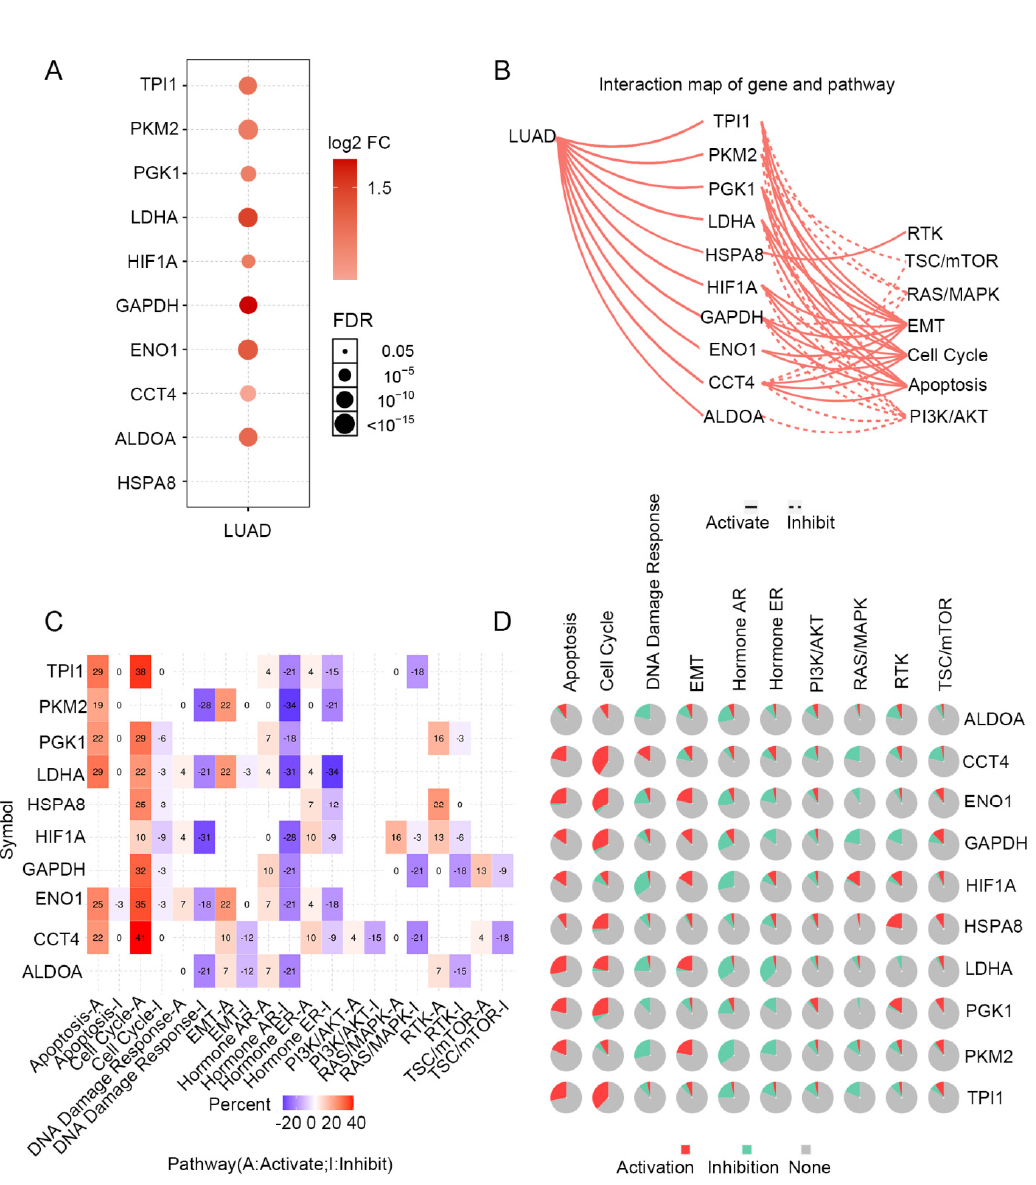
Figure 4. Expression mutation and functional annotation analysis of top 10 co-expressed genes of PGK1. ( A ) mRNA expression of co-expressed genes in LUAD. ( B ) Interaction map of co-expressed genes and pathways. ( C ) The percentage of these genes activating or inhibiting a cancer-related pathway. ( D ) The percentage of cancers in which a gene has an effect on the pathway among 32 cancer types.